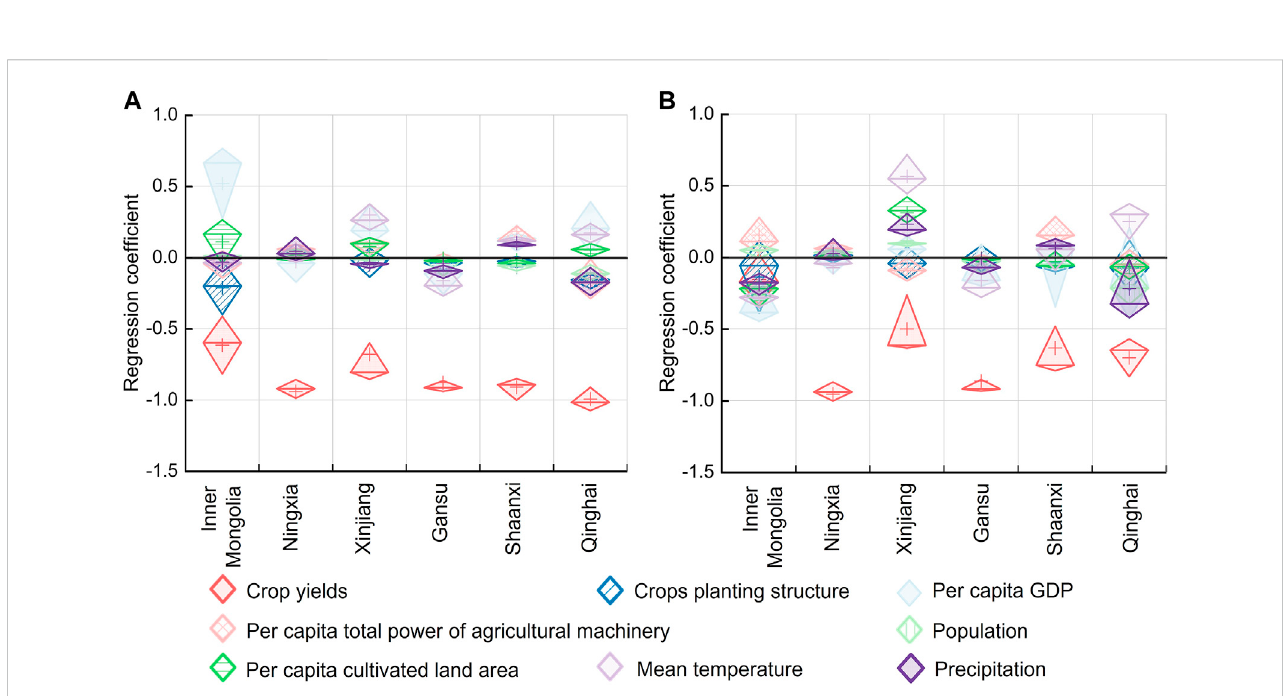
FIGURE 5 Boxplot of the driving force of the unit GWF related to N (A) and P (B) in six western